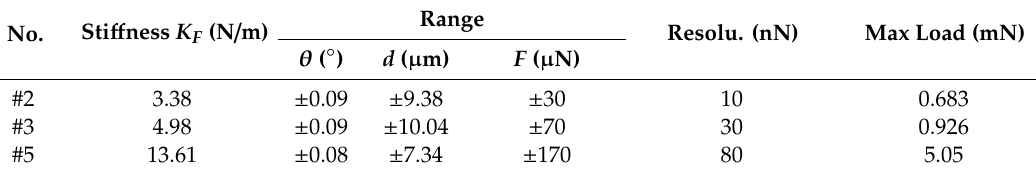
Table 2. Calibration results of the lateral force sensing part and the available normal load of the corresponding hybrid